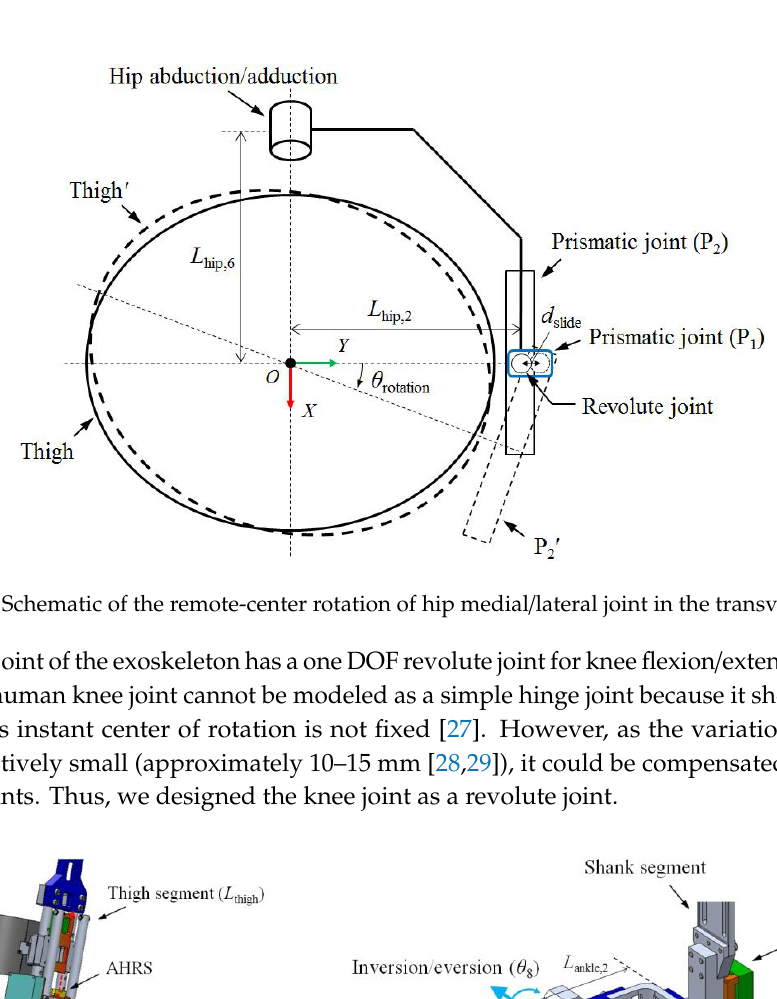
Figure 3. Schematic of the remote-center rotation of hip medial/lateral joint in the transversal view.